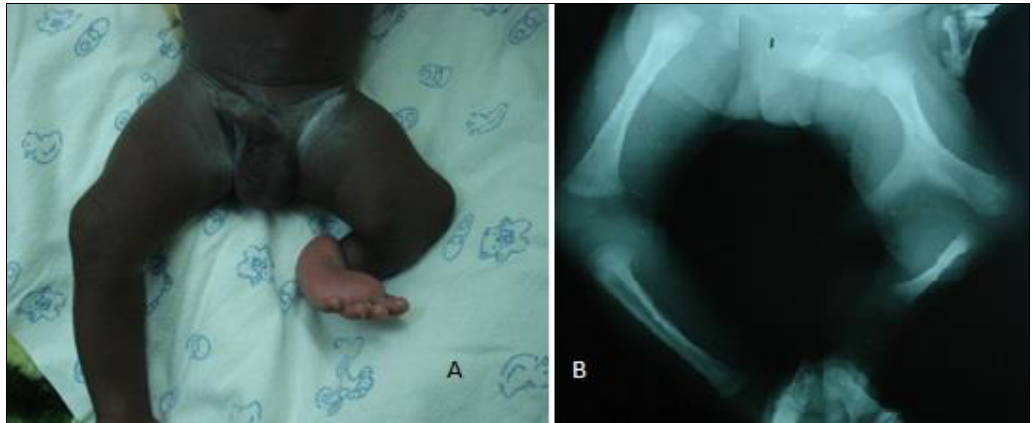
Figure 1: A) Left pelvic limb malformation. B) X-rays showing bifurcated femur, tibia and patella agenesis A full-term, 24-day-old male newborn was admitted with deformed left pelvic limb. He was born of a non- consanguineous couple without any medical history and no notion of congenital malformation in the family. The clinical examination revealed an anteromedial bony protrusion at the left knee, ipsilateral clubfoot and normal contralateral pelvic limb (Fig.1A). X-rays of the left pelvic limb showed a bifid femur with tibia agenesis and absence of the patella (Fig.1B). No further anomaly was found. Gollop-Wolfgang complex diagnosis was